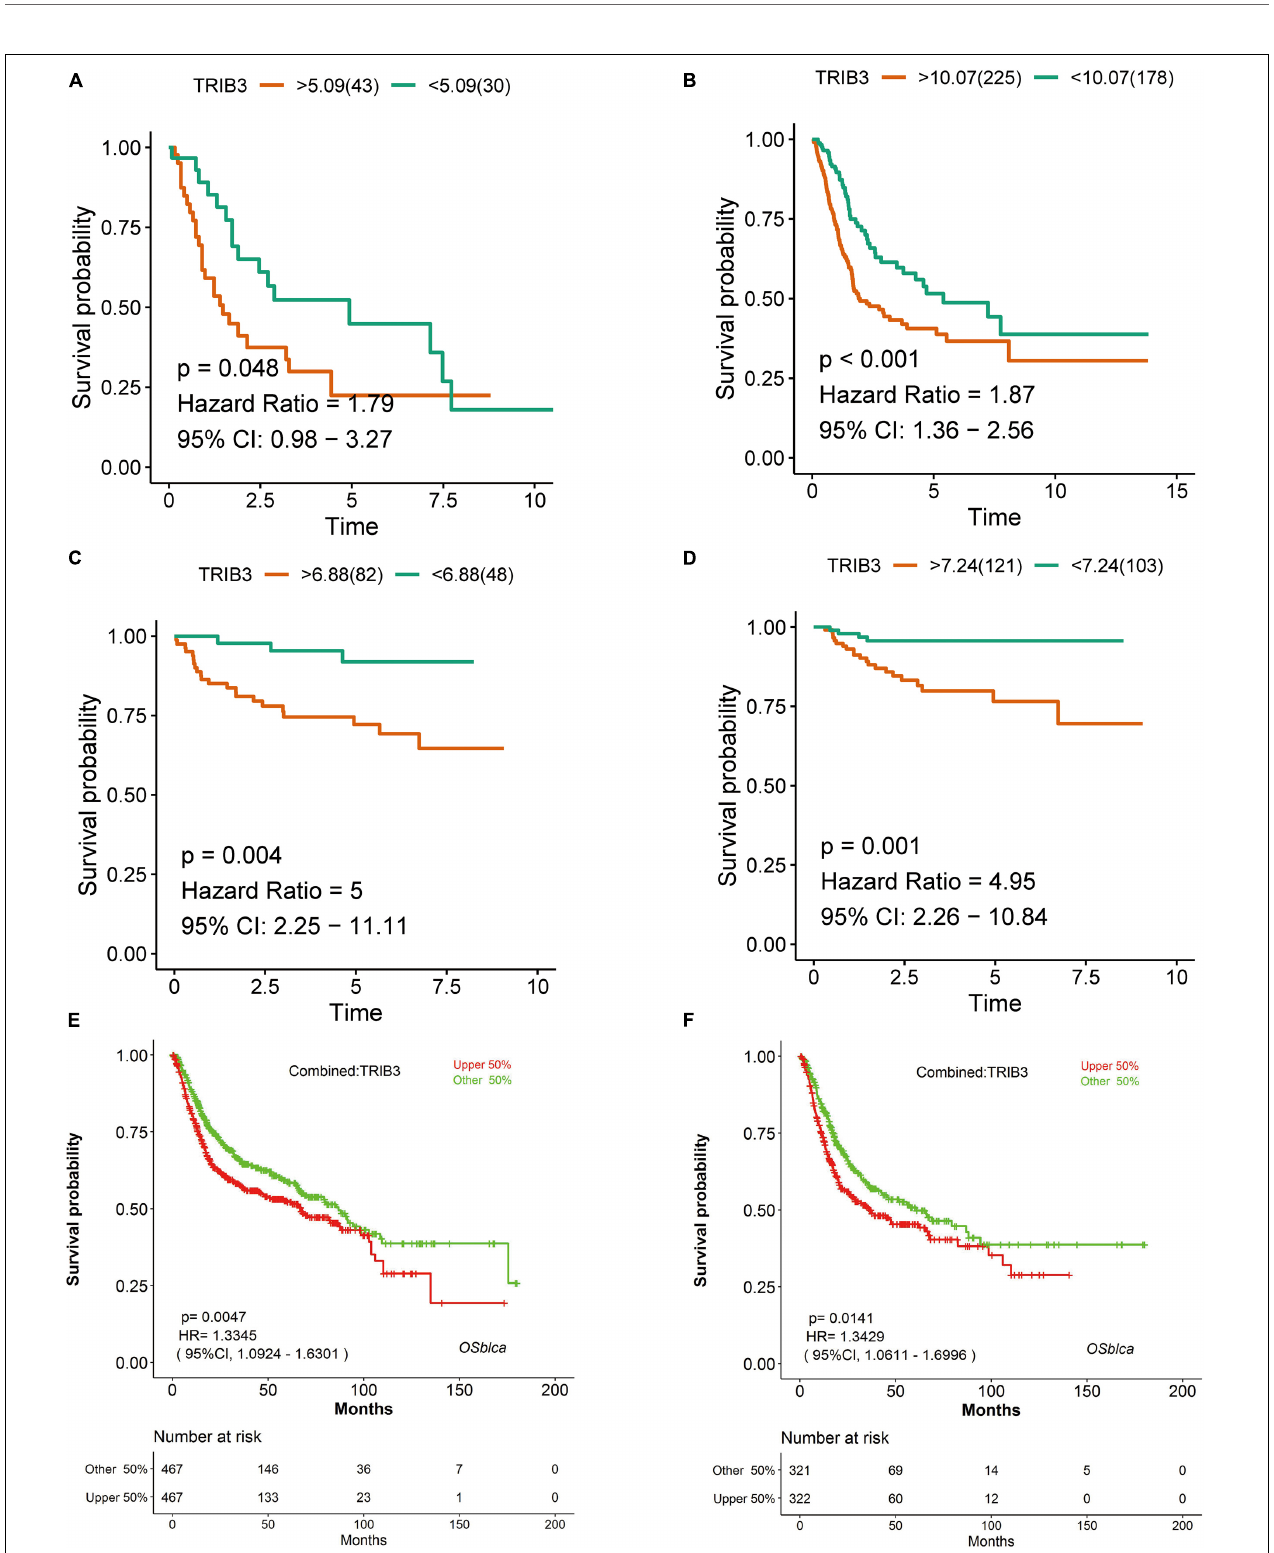
FIGURE 1 | Kaplan–Meier analysis of TRIB3 expression. (A) E-MTAB-1803. (B) TCGA_BLCA. (C) GSE32548. (D) GSE32894. (E) Kaplan–Meier curve of TRIB3 expression in a meta-cohort of bladder cancer. (F) Kaplan–Meier curve of TRIB3 expression in a meta-cohort of muscle-invasive bladder cancer. Red represents the TRIB3 high expression group, green represents the TRIB3 low expression group, and CI represents the confidence interval.